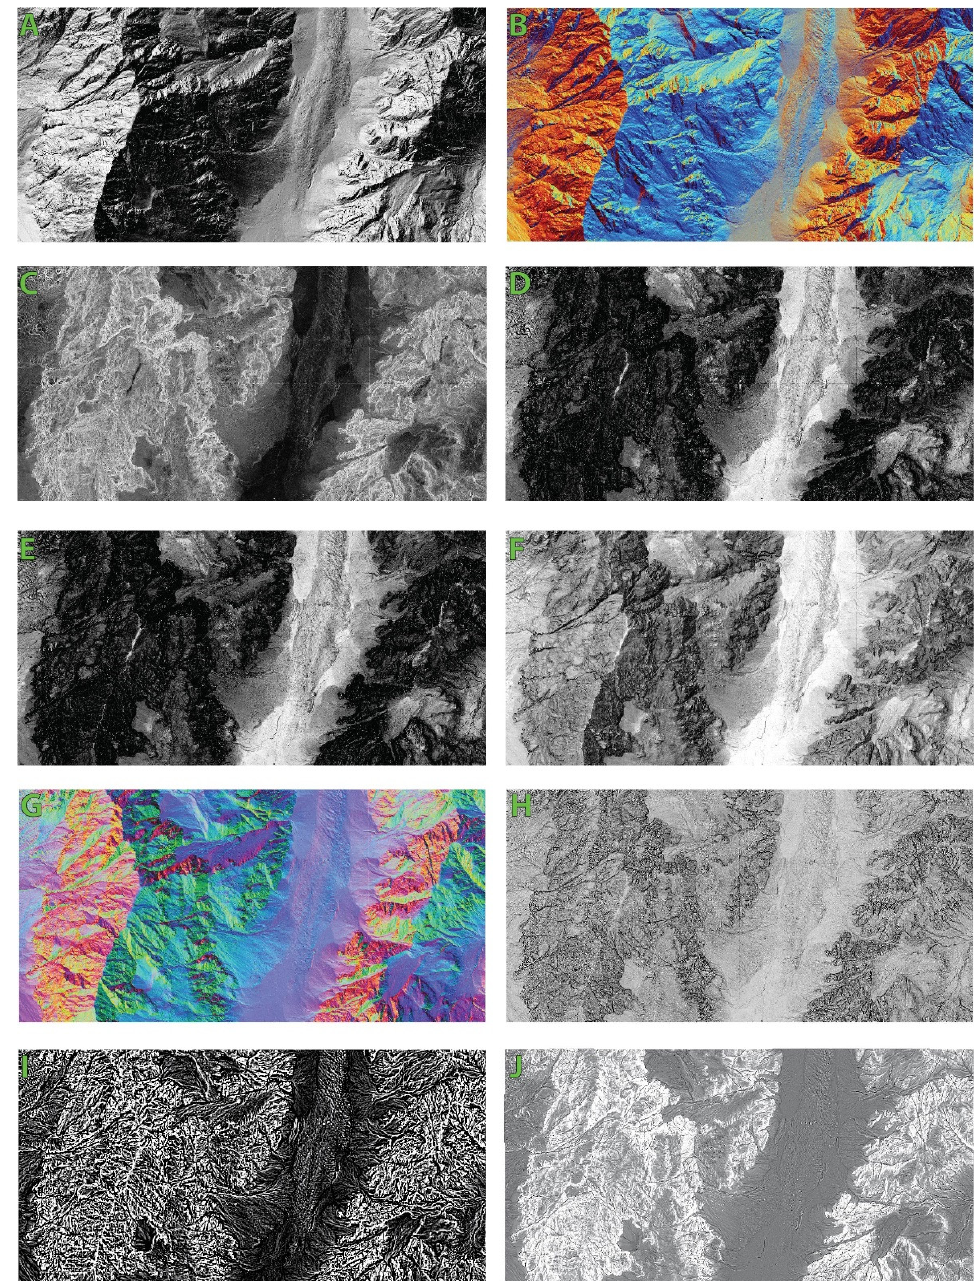
Figure 3. Examples of produced visualisations (for location see rectangle 3 in Figure 1). ( A ) Analytical Hillshading (Azimuth (A) 135, Sun elevation angle (H) 35, 8-bit); ( B ) Hillshading from multiple directions RGB (number of directions (D) 8, H35); ( C ) Slope gradient; ( D ) Slope gradient 8-bit version; ( E ) Sky view factor (radius (R)10, D16 8-bit version); ( F ) Sky view factor allow (R10, D 16 A315); ( G ) Principal component analysis from hillshading (D16, H35); ( H ) Openness positive (R10, D16 8-bit version); ( I ) Simple local relief model (Radius of trend assessment: 20); ( J ) Local dominance (minimum radius: 10, maximum radius